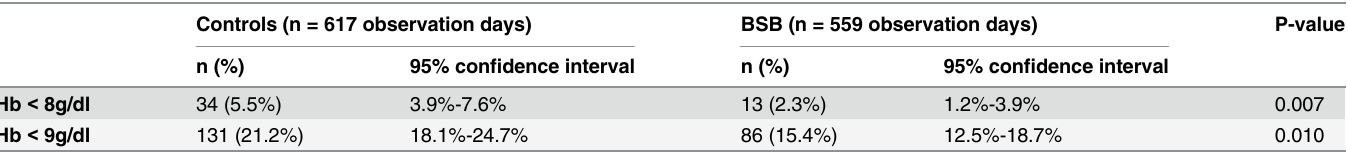
Table 3. Absolute number and percentage of observation days with hemoglobin concentrations < 8 g/dl and < 9